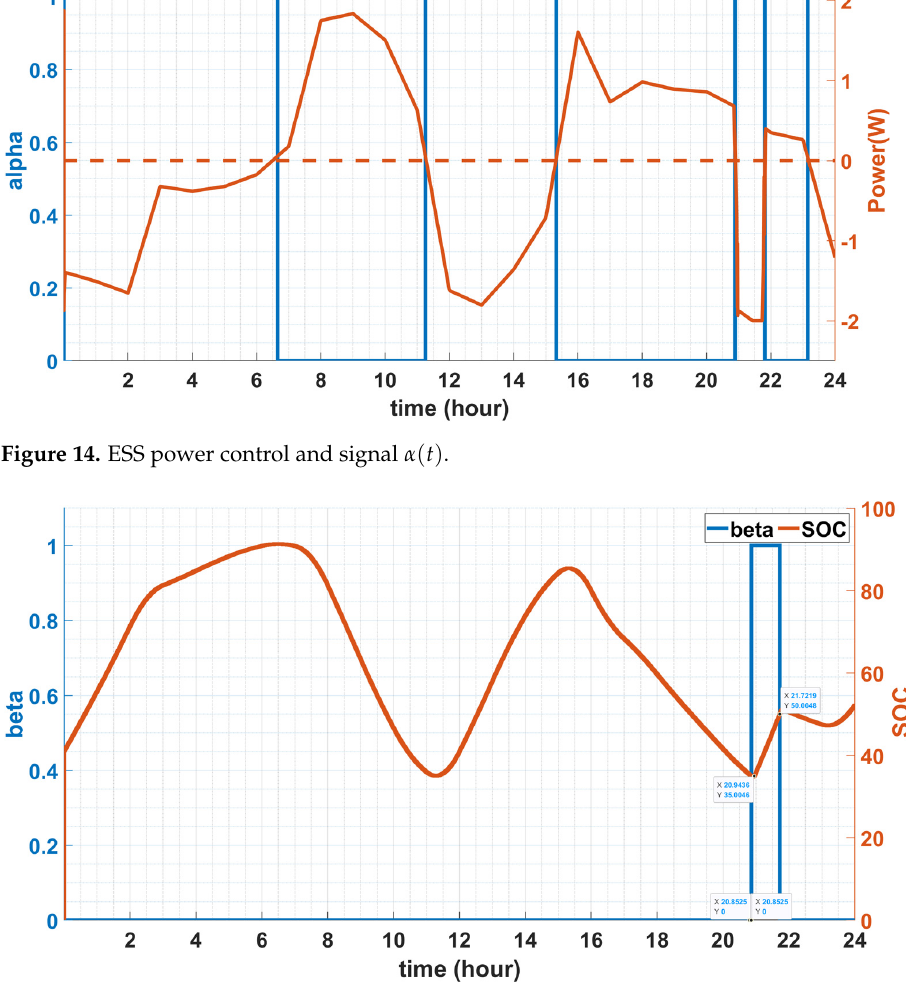
Figure 15. DG2 On/Off control due to the SOC and signal 𝛽(𝑡) .